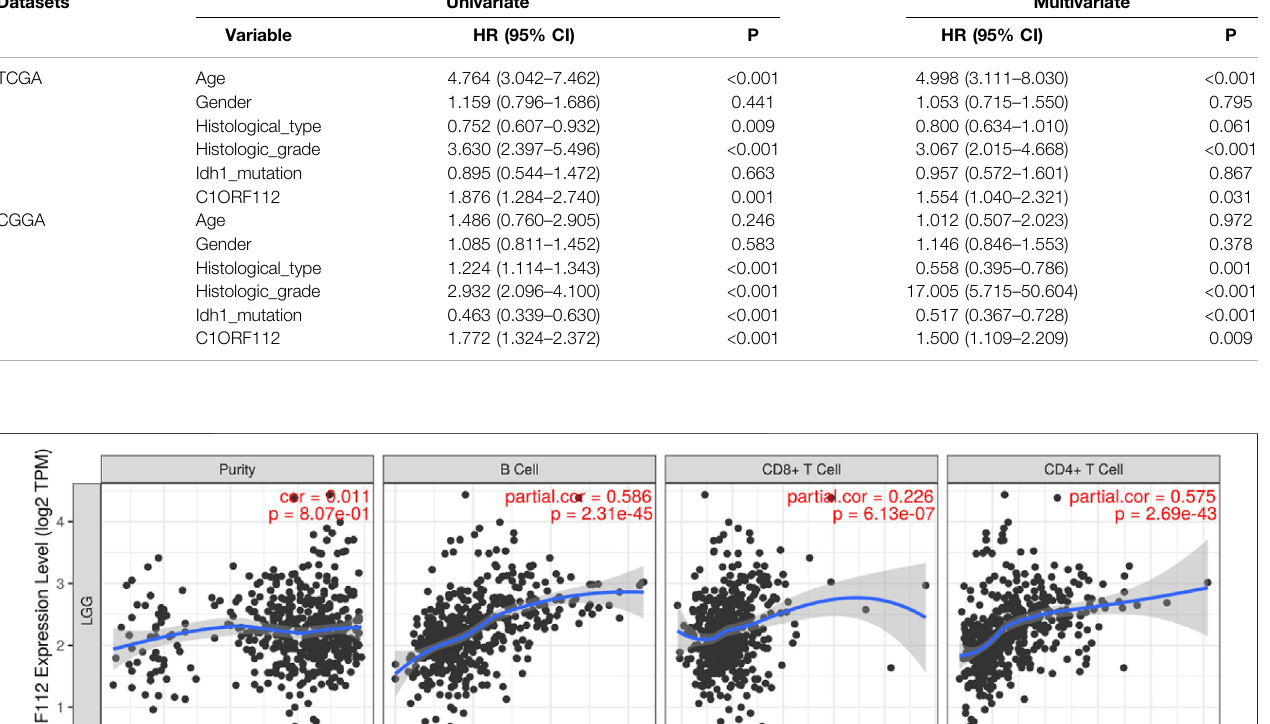
TABLE 2 | Univariate and multivariate analysis of C1ORF112 expression pro fi le in TCGA database and CGGA database. Datasets